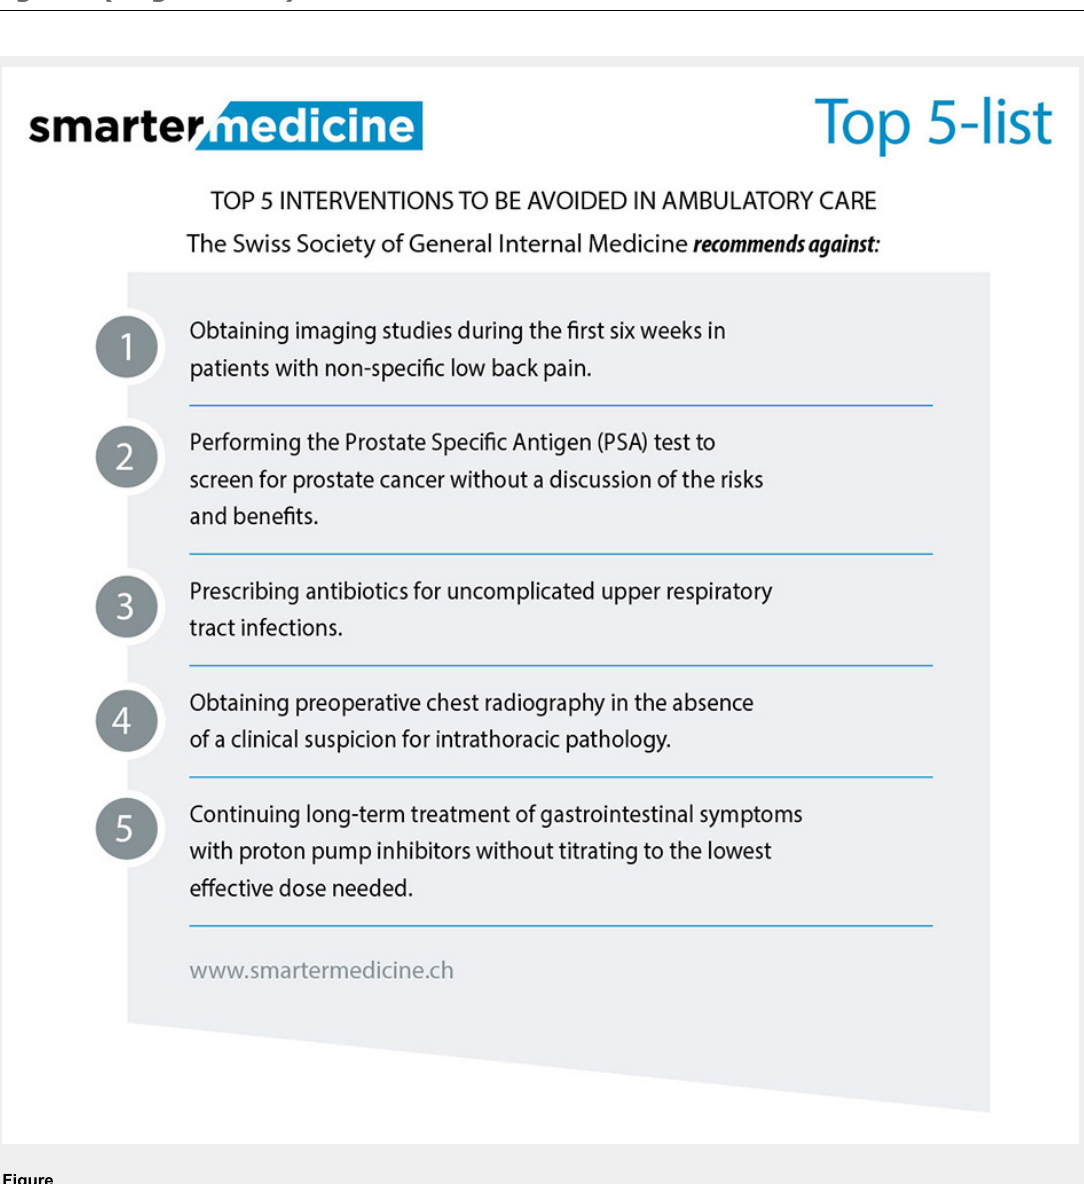
Top five list of the Swiss Society of General Internal Medicine. May